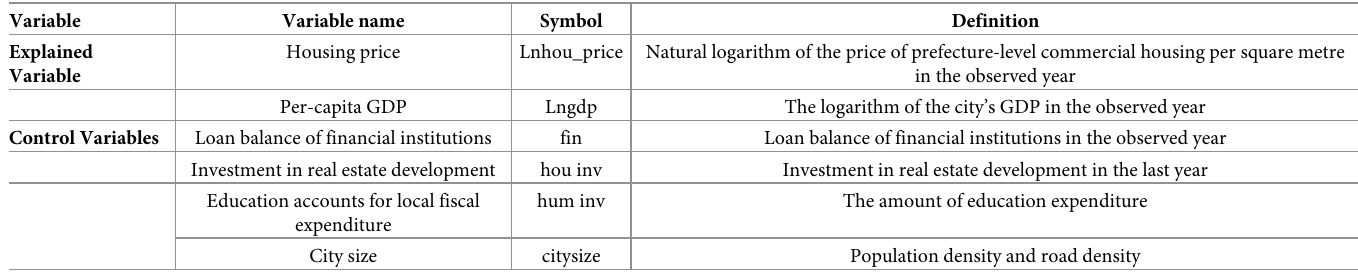
Table 1. Explanatory variables and definitions.